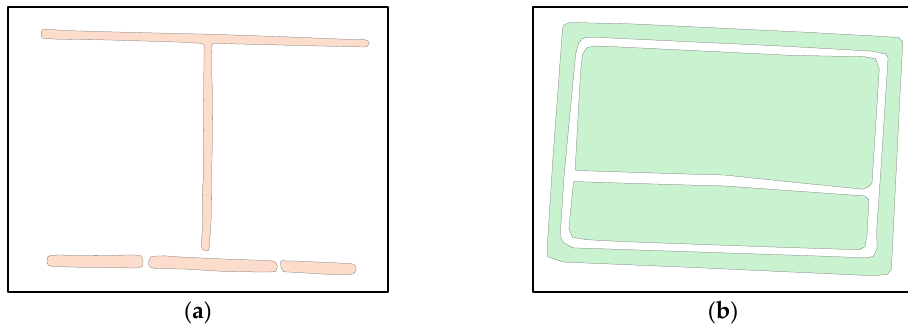
Figure 2. Same lakes at different scales and convex hulls of the lakes: ( A ) Polygon A is the lake in scale of 1:10,000, ( B ) polygon B is the lake in scale of 1:50,000, ( C ) polygon C is convex hull of polygon A; and ( D ) polygon D is convex hull of polygon B. ISPRS Int. J. Geo-Inf. 2018 , 7 , x FOR PEER REVIEW